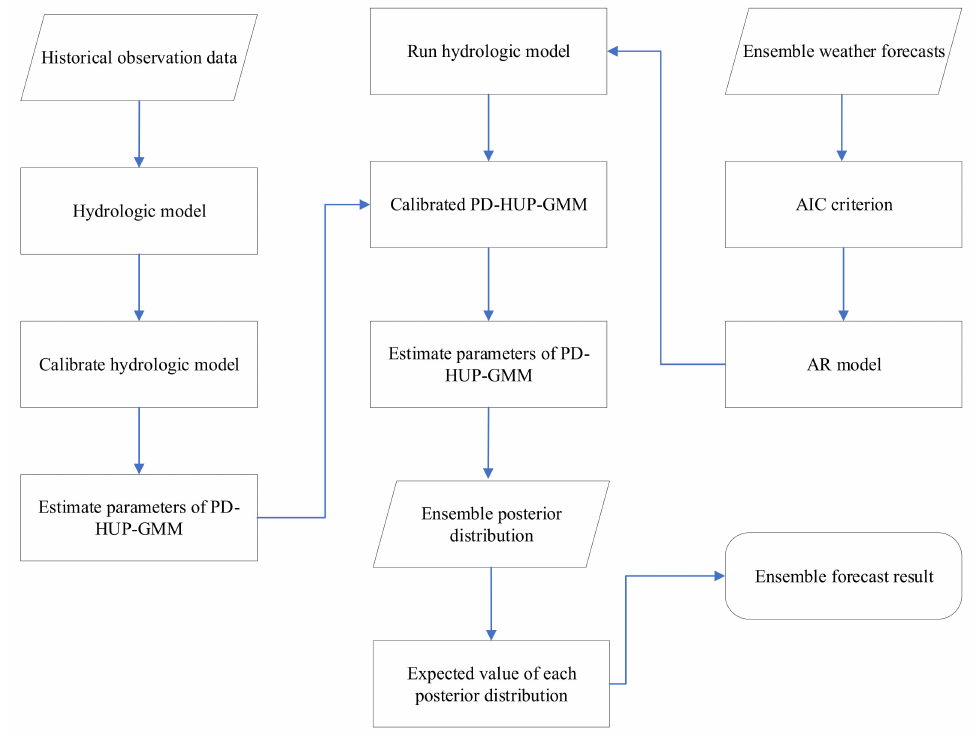
Figure 1. Flow of methods. The PD-HUP-GMM represents the precipitation-dependent hydrological uncertainty processor (PD-HUP) based on a Gaussian mixture model